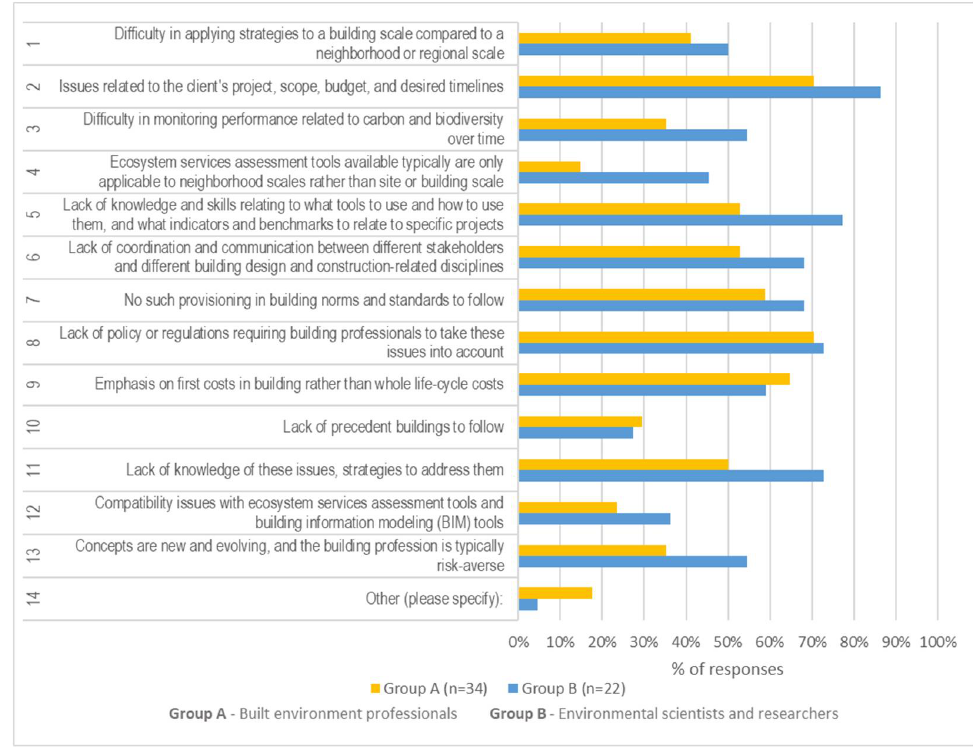
Figure 18. Barriers to implementing habitat provisioning and carbon sequestration strategies.